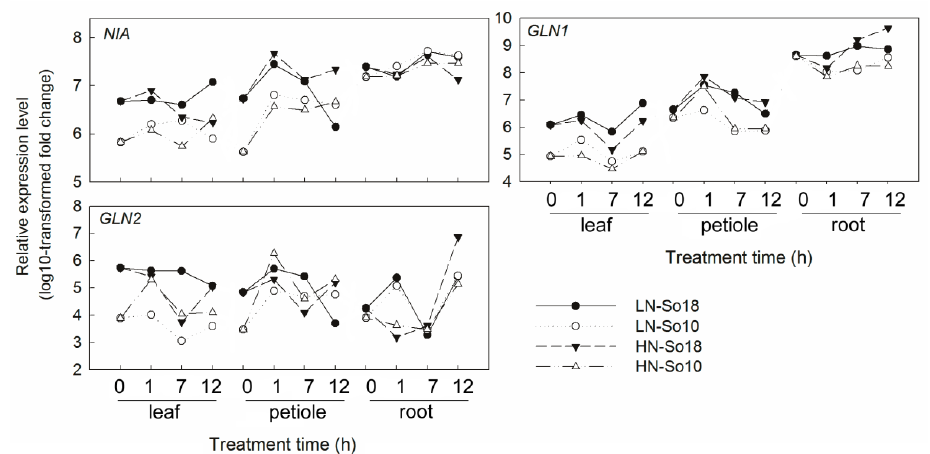
Figure 7. Expression analysis of nitrogen assimilation genes in leaf blades, petioles and roots of two spinach varieties under two concentrations (0.5 and 15 mmol · L − 1 ) of nitrate treatments by qRT-PCR. All values represent the averages of three replicates (see Supplementary Table S1 for details). LN-So18, So18 treated with low nitrate concentration; LN-So10, So10 treated with low nitrate concentration; HN-So18, So18 treated with high nitrate concentration; and HN-So10, So10 treated with high nitrate concentration.